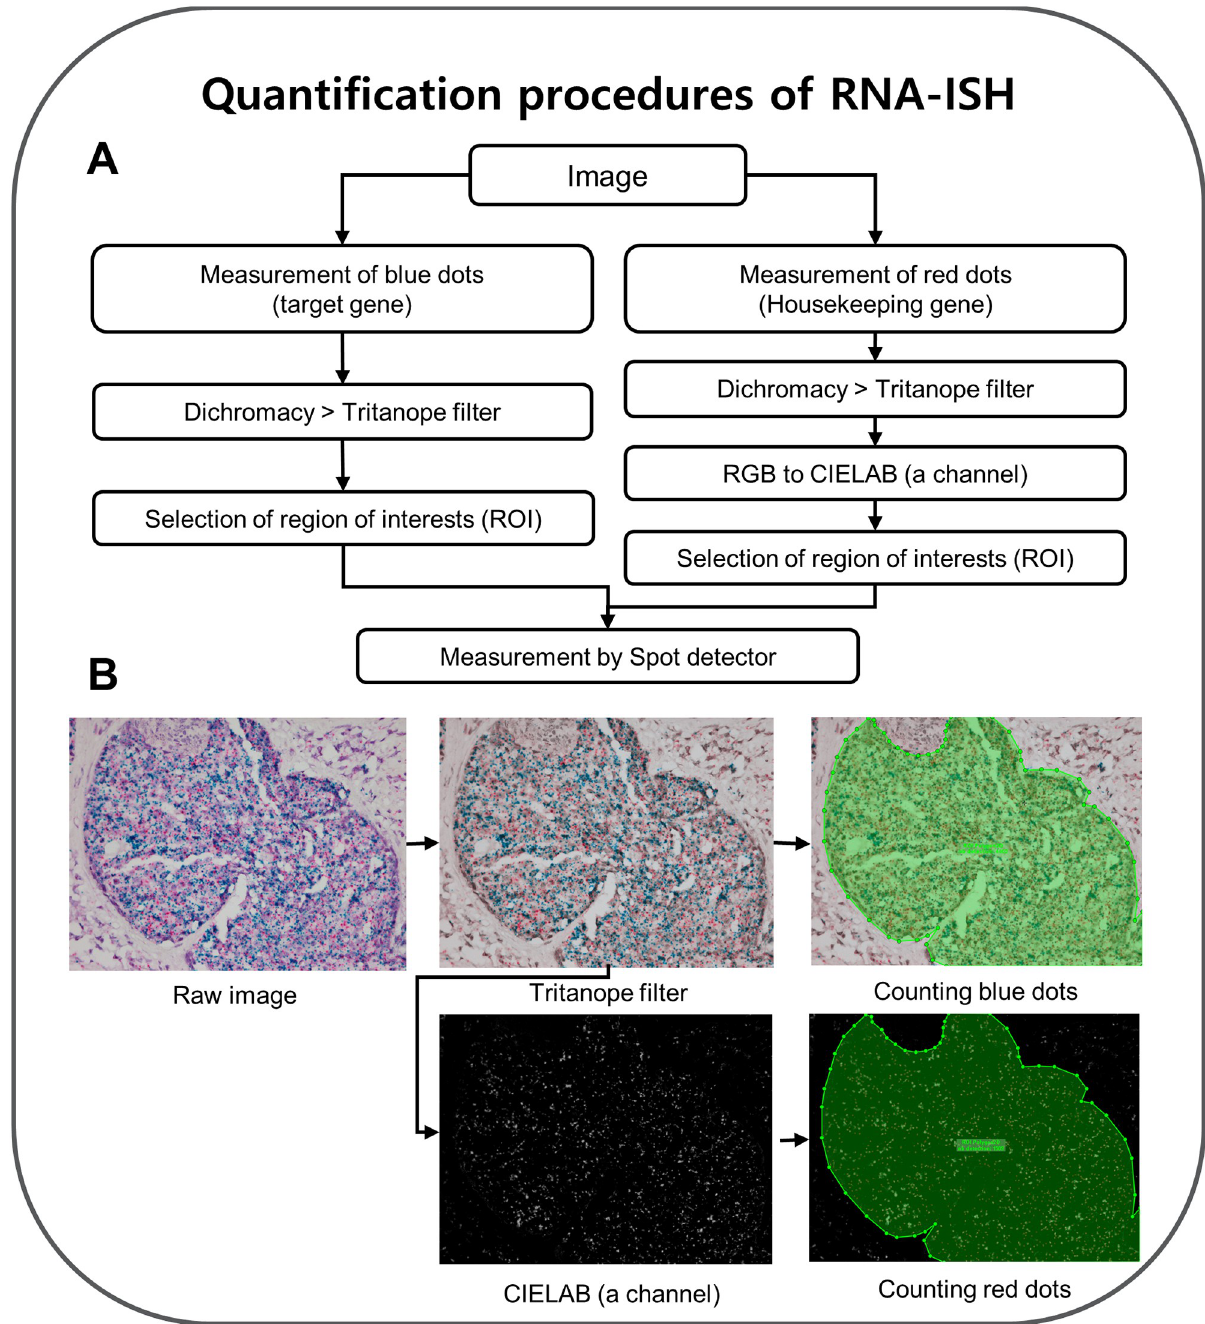
Fig 1. Workflow of quantification procedures of RNA-ISH. (A) Flow chart for quantitative analysis of RNA-ISH images. (B) Representative RNA-ISH raw images are converted using each filter, and quantitative analysis is automatically performed using the spot detection software.